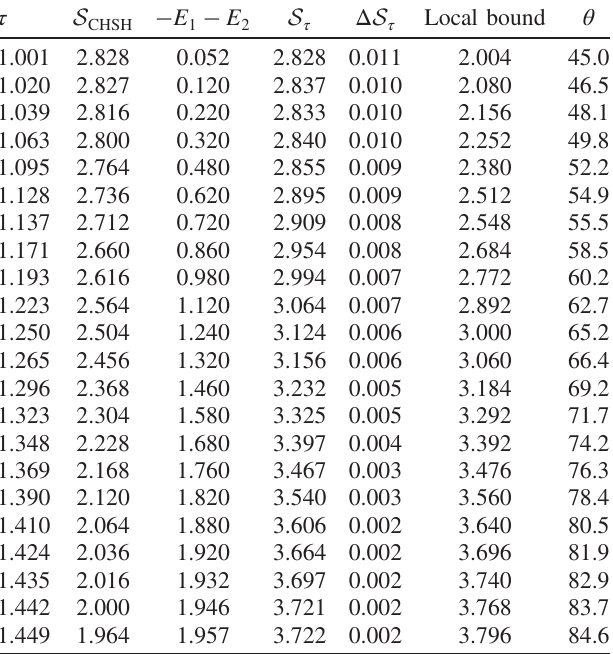
TABLE II. Analyzed data and estimated parameters for the tilted Bell inequality [Eq. (7)]. Here, the estimate of the uncertainty of S τ is given by Δ S τ .